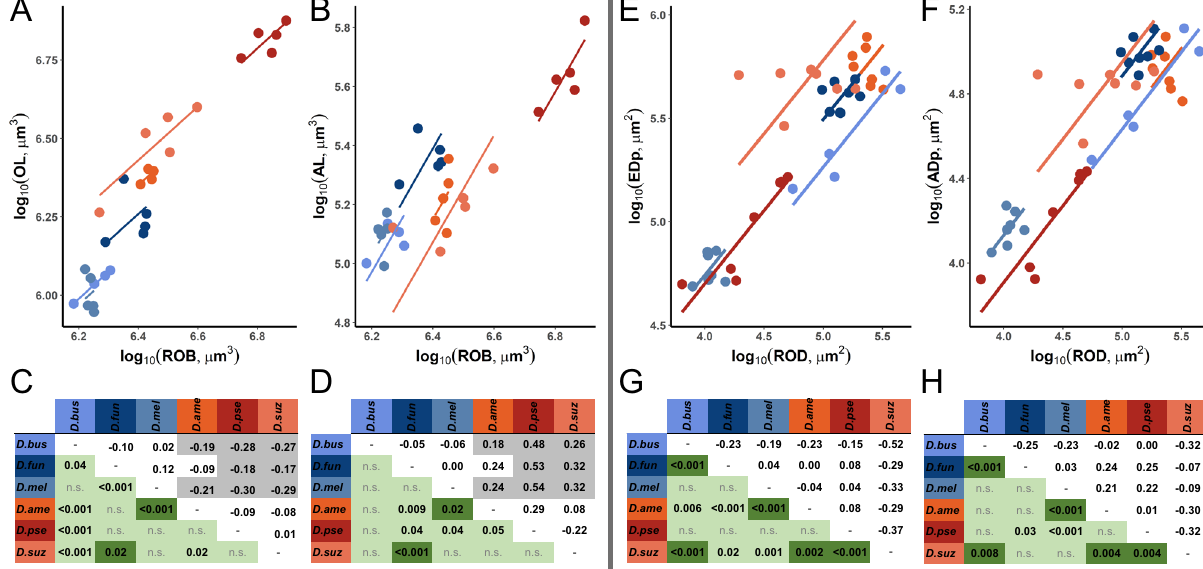
Fig. 2 Analysing scaling relationships of vision and olfaction related structures in the brain and eye-antennal imaginal discs reveals a lack of inverse relationships between vision and olfaction despite strong variation in scaling between six Drosophila species. ( A – B , E – F ) The top row displays a plot of the visual and olfactory portion against the relevant allometric control (Rest of Brain, RoB, or Rest of Disc, RoD). Regression lines were derived from a SMATR 12 analysis, where slope differences could not be detected. The analysis revealed intercept differences, after which a species pair-wise analysis was conducted. ( C – D , G – H ) This pair-wise analysis (based on the Wald statistic) is displayed in the bottom row. The green diagonal displays the signi fi cance of pair-wise differences. If the pair showed signi fi cant differences in the visual and olfactory portion this is indicated by dark green. The off diagonal indicates the difference between the intercepts. Opposing signs of intercept differences between C and D or G and H could indicate an inverse relationship between a speci fi c species pair where one structure is traded off against another. Cases which fi t this description and show a shift are indicated by a grey background (excluding pair-wise comparisons with minor (<0.1 units) differences). Abbreviations: OL: optic lobe, AL antennal lobe, ROB rest of brain, EDp eye disc portion, ADp antennal disc portion, ROD rest of disc, n.s. not signi fi cant; D.bus = D. busckii ( N = 4 brains ; N = 5 imaginal discs), D.fun = D. funebris ( N = 5; N = 8) , D.mel = D. melanogaster ( N = 5; N = 7) , D.ame = D. americana ( N = 5; N = 7) , D.pse = D. pseudotalamancana ( N = 5; N = 7) , D.suz = D. suzukii ( N = 5; N = 7). Source data are provided as a Source Data fi